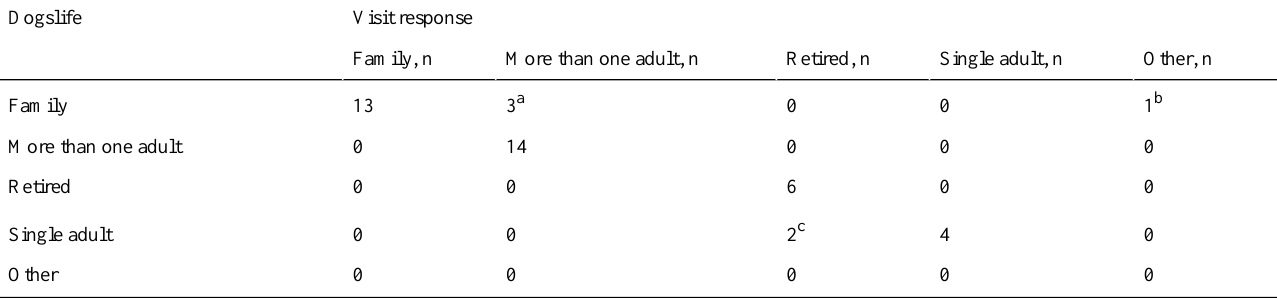
Table 1. Comparison of household type in Dogslife record with visit response. Numbers entered refer to the count of households. Visit responseDogslife